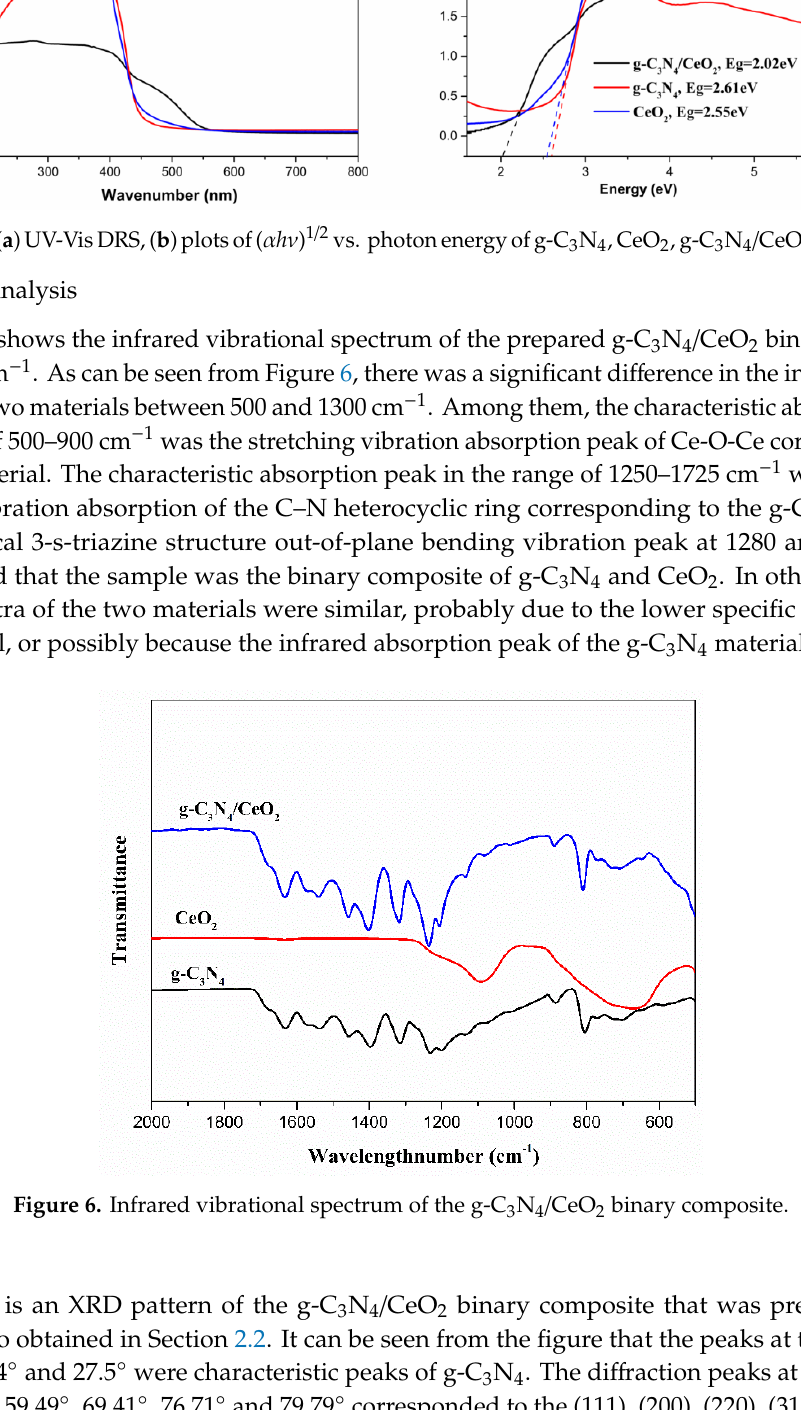
Figure 6. Infrared vibrational spectrum of the g-C 3 N 4 /CeO 2 binary composite.